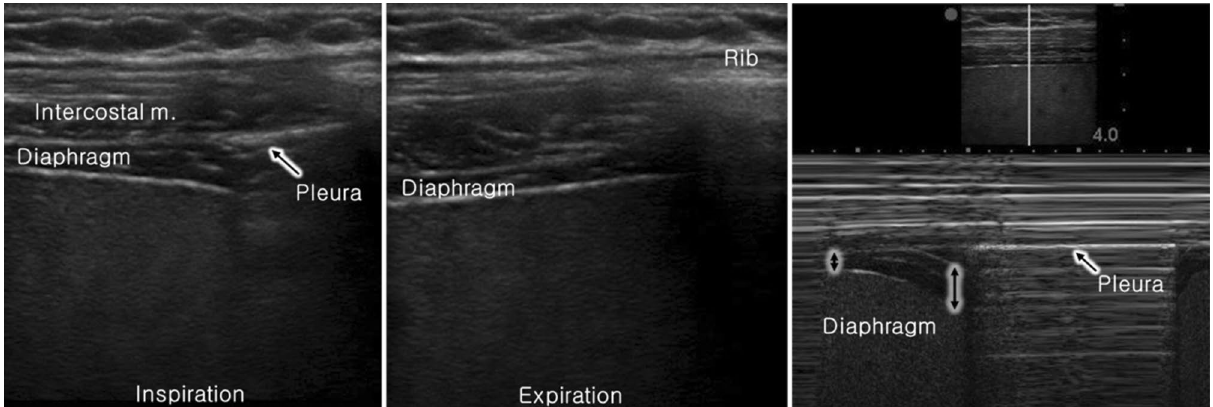
Figure 2. Diaphragm thickness fraction (DTF) measurement. DTF = thickness at end inspiration − thickness at end expiration/thickness at end expiration. Hemidiaphragmatic paralysis was defined as DTF <